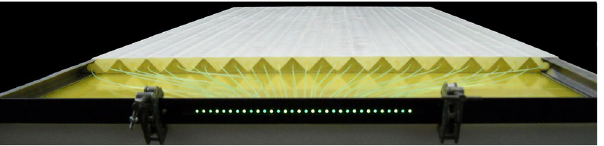
Figure 6. A half plane of 32 scintillator bars and 32 wavelength shifting fibres placed in a connector. The connector is optically coupled to 32 Silicon photomultipliers, mounted on a printed circuit board, not shown in the picture. Two half planes mounted side by side form a detection plane.